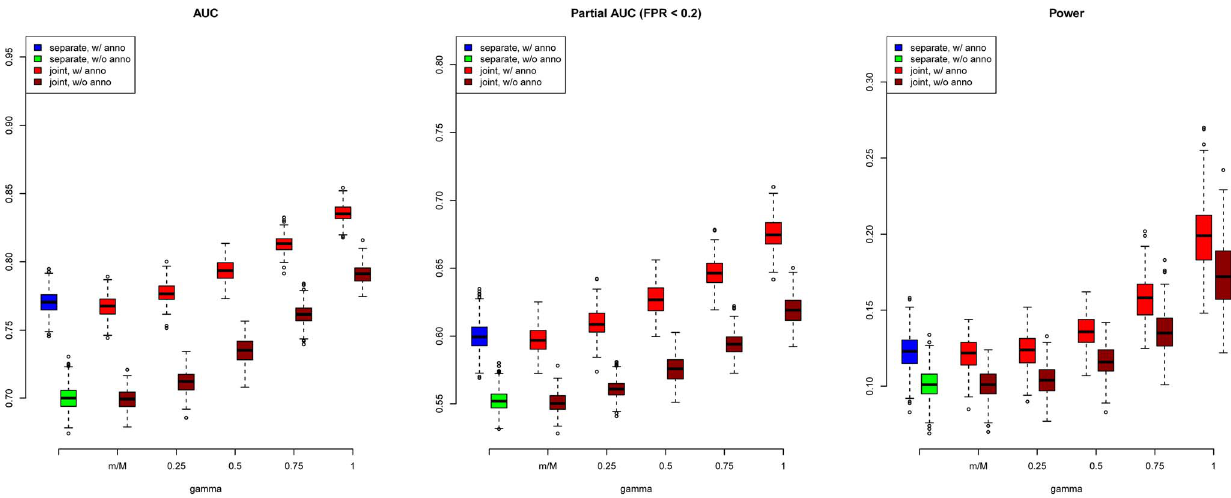
Figure 1. AUC (left), partial AUC (Middle) and power (right) of GPA for SNP prioritization with sample size N =5000 and number of risk SNPs m =1000. The results are based on 200 simulations.